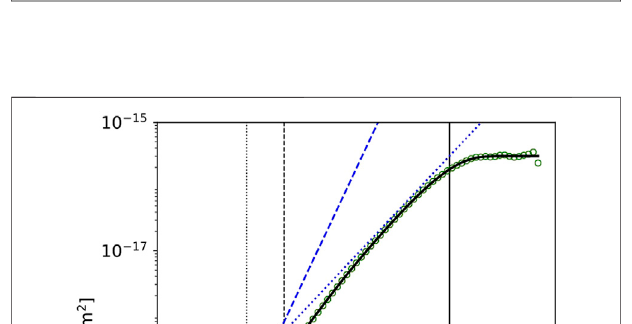
FIGURE 4 | Experimental power spectral density for a 2 . 15 μ m diameter polystyrene particle covered with gold nanoparticles (AuPS) at an ambient temperature of T 0 (cid:2) 23 . 5 ° C. The found trap stiffness corresponds to k (cid:2) 25 . 7pN / μ matatrappingpowerof P (cid:2) 15 mW.Allsymbolshavethe same meaning as in Figure 2 .